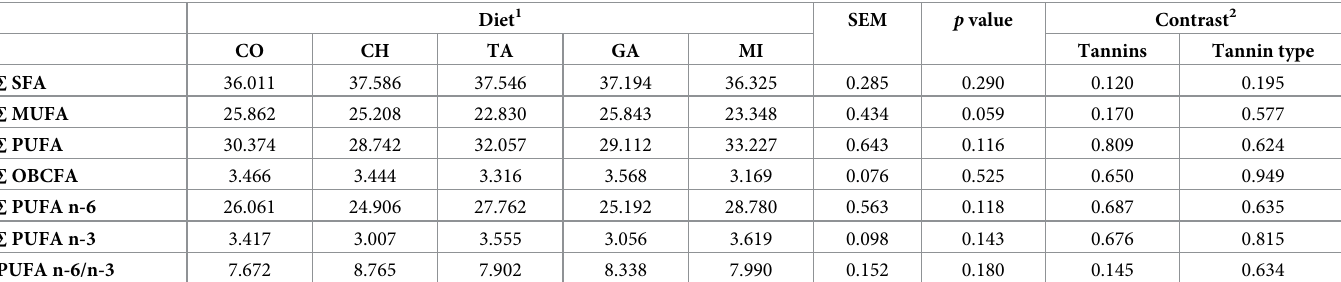
Dietary treatment means within a row with different superscripts differ at a significance of P �